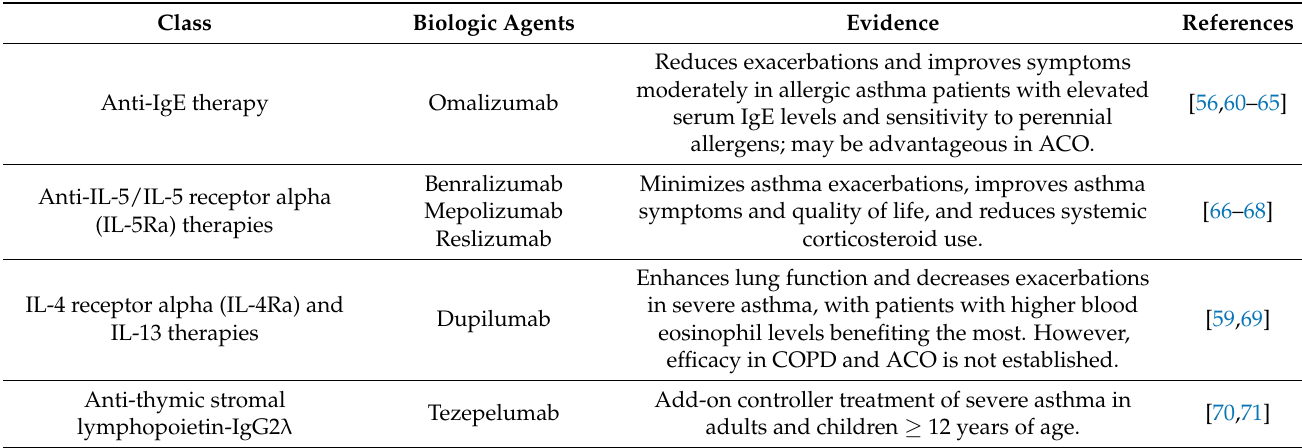
Table 5. The use of biologic agents in patients with ACO